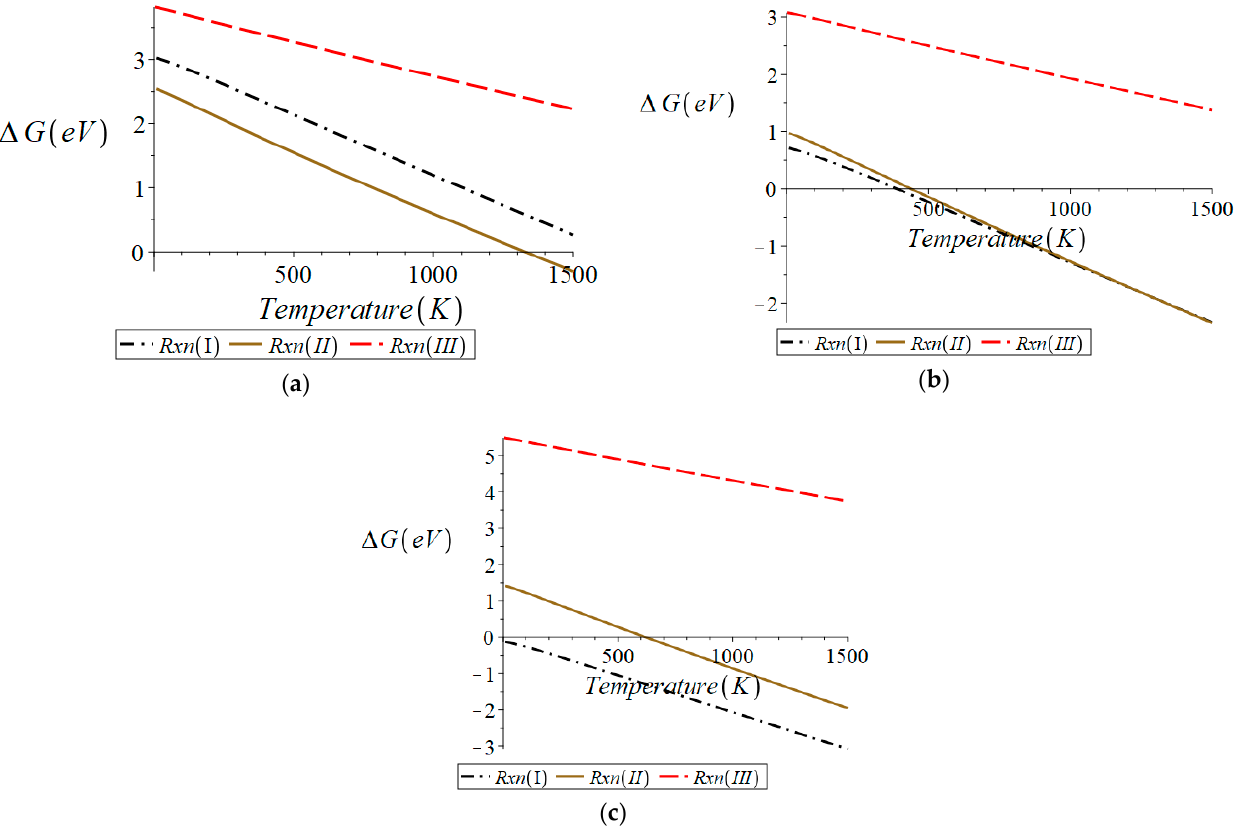
Figure 2. Surface of orthorhombic BCF8515 for ( a ) oxygen-vacancy-free surface, ( b ) surface with 1 oxygen vacancy, ( c ) surface with 2 oxygen vacancies. Plots were generated in Maple TM